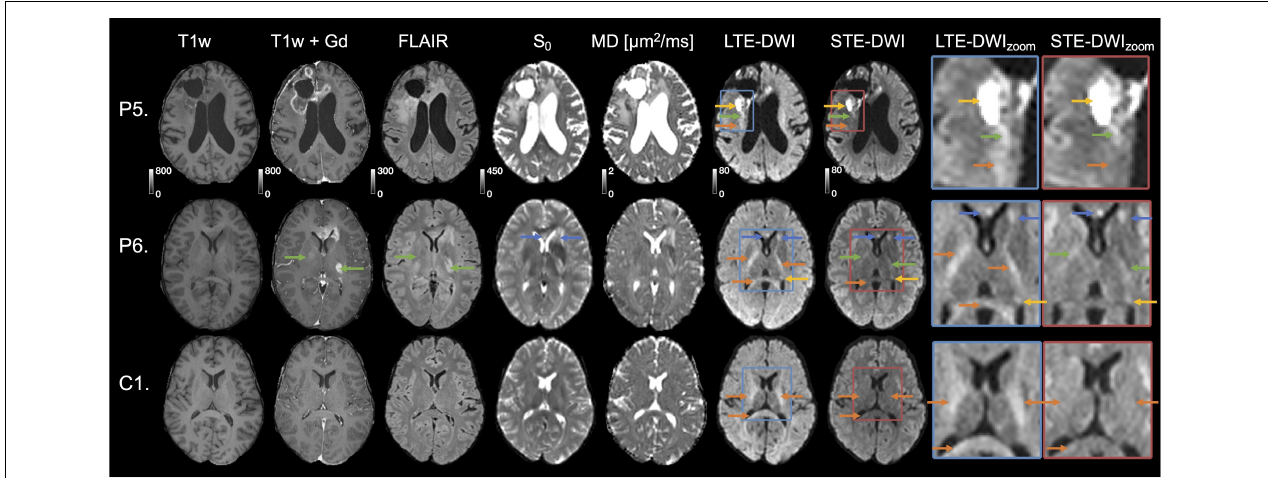
FIGURE 5 | Interpretation challenges: Examples where inclusion of STE-DWI could improve diagnostic confidence. The top row (patient P5) shows images obtained after initiation of therapy (Optune) from a 62-year-old male diagnosed with glioblastoma grade IV (wild-type IDH, non-methylated MGMT). The tumor-related hyperintensity (yellow arrows) is with LTE-DWI surrounded by what appears to be hyperintense white matter (orange arrow). However, only parts of what may be interpreted as hyperintense white matter on LTE-DWI is attenuated with STE-DWI (orange arrow). The part closer to the main lesion remains hyperintensed with STE-DWI (green arrow), which suggests that it is a tumor-related hyperintensity. The middle row (P6) shows images obtained to confirm tumor progression in a 31-year-old male diagnosed with glioblastoma grade IV (mutated IDH). Several LTE-DWI and STE-DWI hyperintensities can be observed, however, STE-DWI suppresses those related to white matter (orange arrows) and, thereby amplifies the contrast of those that are not white-matter related. Out of these, two may be due to T2 shine-through effect (blue arrows). Some of the STE-DWI hyperintensities were “hidden” with LTE-DWI under the white matter-related hyperintensities (green arrows). The STE-DWI suggests that they may be tumor-related hyperintensities coming from tumor cells spreading along the white matter tracts. Note that these tracts are surrounded by Gd-enhancements and T2 FLAIR hyperintensity (green arrows). The bottom row shows images obtained in a subject (C1) without relevant MRI abnormalities in the region evaluated to illustrate that—unlike in the previous case—all white-matter-related hyperintensities seen with LTE-DWI disappear with STE-DWI (orange arrows).